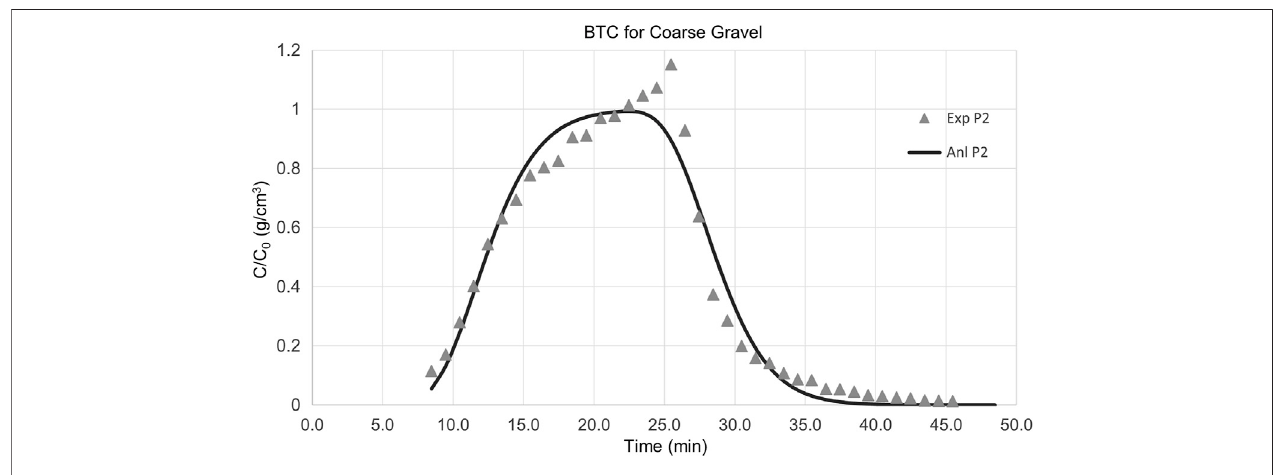
FIGURE 7 | BTCs of plastic particle experiment P2 for coarse gravel.